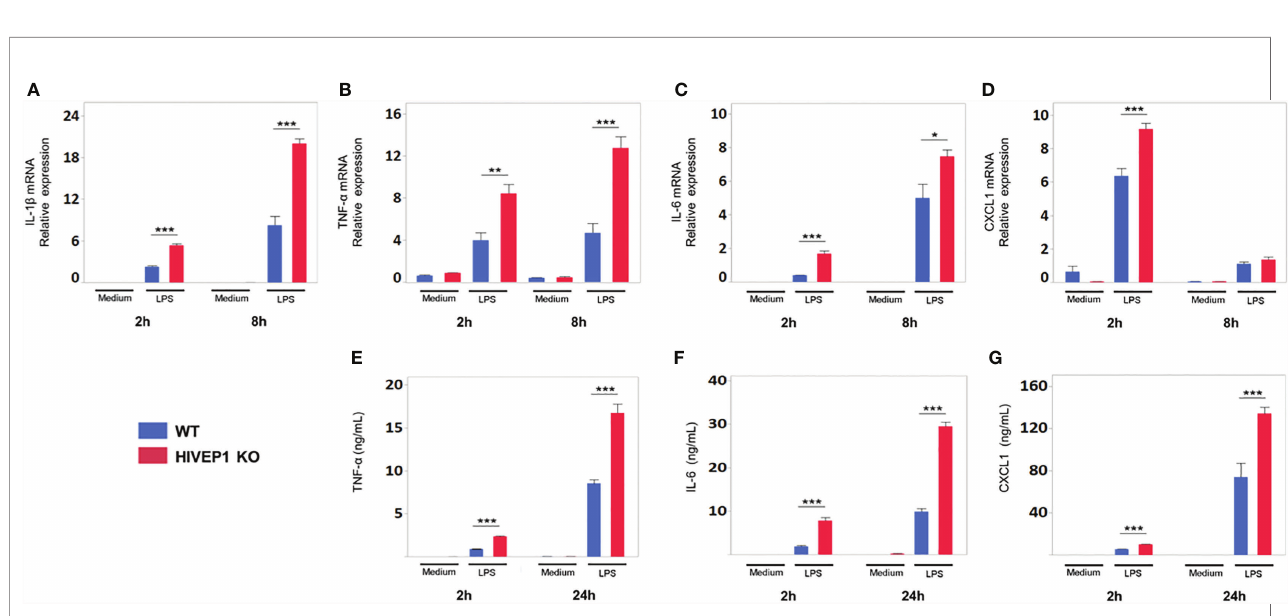
FIGURE 4 | HIVEP1-de fi cient murine macrophages show increased proin fl ammatory cytokine production upon stimulation with LPS. Bone marrow derived macrophages from hivep1 -/- mice and wild type littermates were stimulated with LPS (100 ng/mL). Hivep1 -/- macrophages showed increased expression of TNF- a , IL-1 b , IL-6, CXCL1 mRNA upon LPS stimulation (A – D) , as well as enhanced TNF- a , IL-6 and CXCL1 protein release (E – G) . Data shows means ± SEM and were pooled from three independent data set [n = 4 (A – D) or n = 12 (E – G) for each condition within each experiment)]. *P < 0.05, **P < 0.01, ***P <